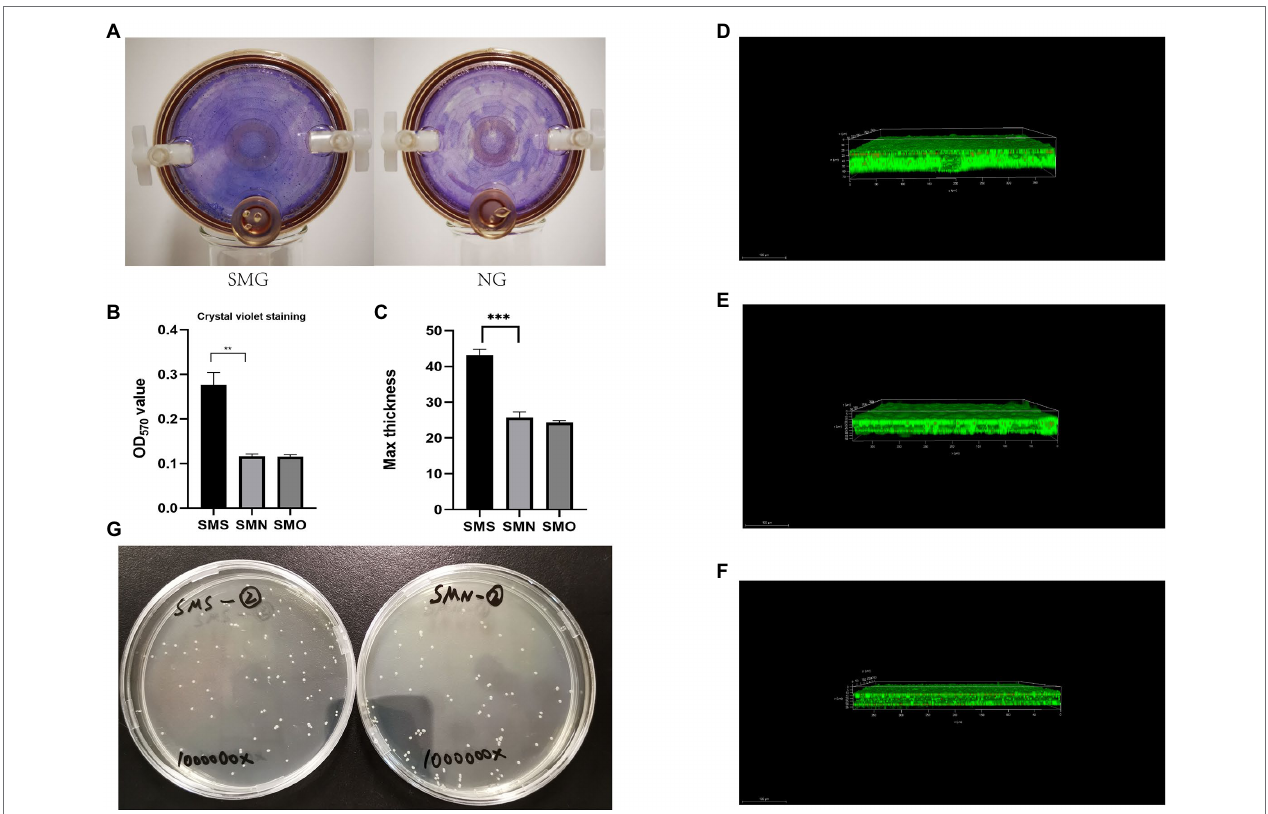
FIGURE 4 | Biofilm formation assay. (A) Quantitative analysis of biofilm formation ability via crystal violet. The three groups were cultured in 24-well plate at 37 ° C and 200 rpm for 24 h. Biofilm formation ability was measured by determining the OD 570 of crystal violet. (B) Quantitative analysis of biofilm formation ability via crystal violet. The three groups were cultured in 24-well plate at 37 ° C and 200 rpm for 24 h. Biofilm formation ability was measured by determining the OD570 of crystal violet. (C) Biofilms of SMS, SMN, and SMO cultured in 35-mm confocal dished. Cells were stained with a Filmtracer ™ (LIVE/DEAD Biofilm Viability Kit), and biofilm formation ability was detected using confocal laser-scanning microscopy (CLSM). Green fluorescence indicates live cells and red fluorescence indicates dead cells. The maximum thickness of biofilm of SMS, SMN, and SMO were (43.17 ± 2.73; 25.75 ± 1.59), and (25.36 ± 1.56) μ m, respectively. ** p < 0.01 and *** p < 0.001. (D) Analysis of biofilm formation ability of SMS samples using CLSM. (E) Analysis of biofilm formation ability of SMN samples using CLSM. (F) Analysis of biofilm formation ability of SMO samples using CLSM. (G) Colony forming unit (CFU) assay of SMS and SMN